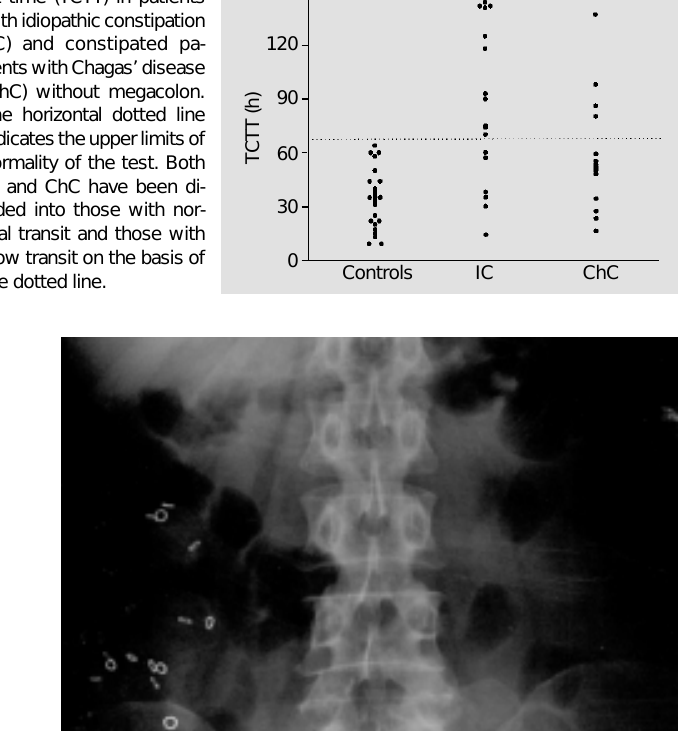
Figure 1 - Total colonic tran- sit time (TCTT) in patients with idiopathic constipation (IC) and constipated pa- tients with Chagas’ disease (ChC) without megacolon. The horizontal dotted line indicates the upper limits of normality of the test. Both IC and ChC have been di- vided into those with nor- mal transit and those with slow transit on the basis of the dotted line.